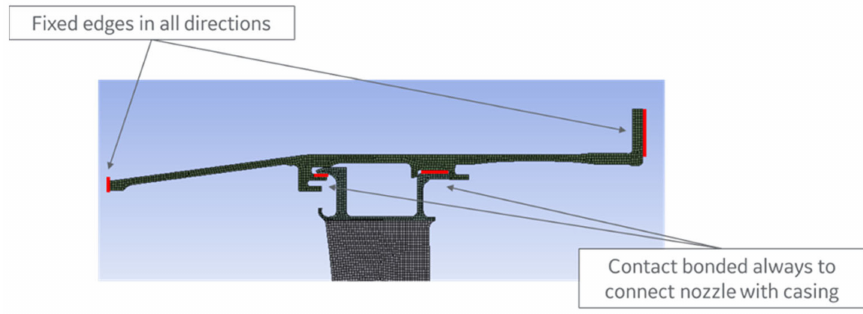
Figure 11. FEM model: boundary conditions and contact area between nozzle and casing.